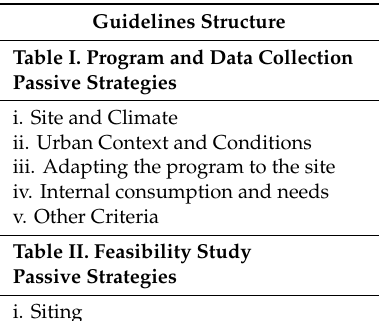
Table II. Feasibility Study Passive Strategies